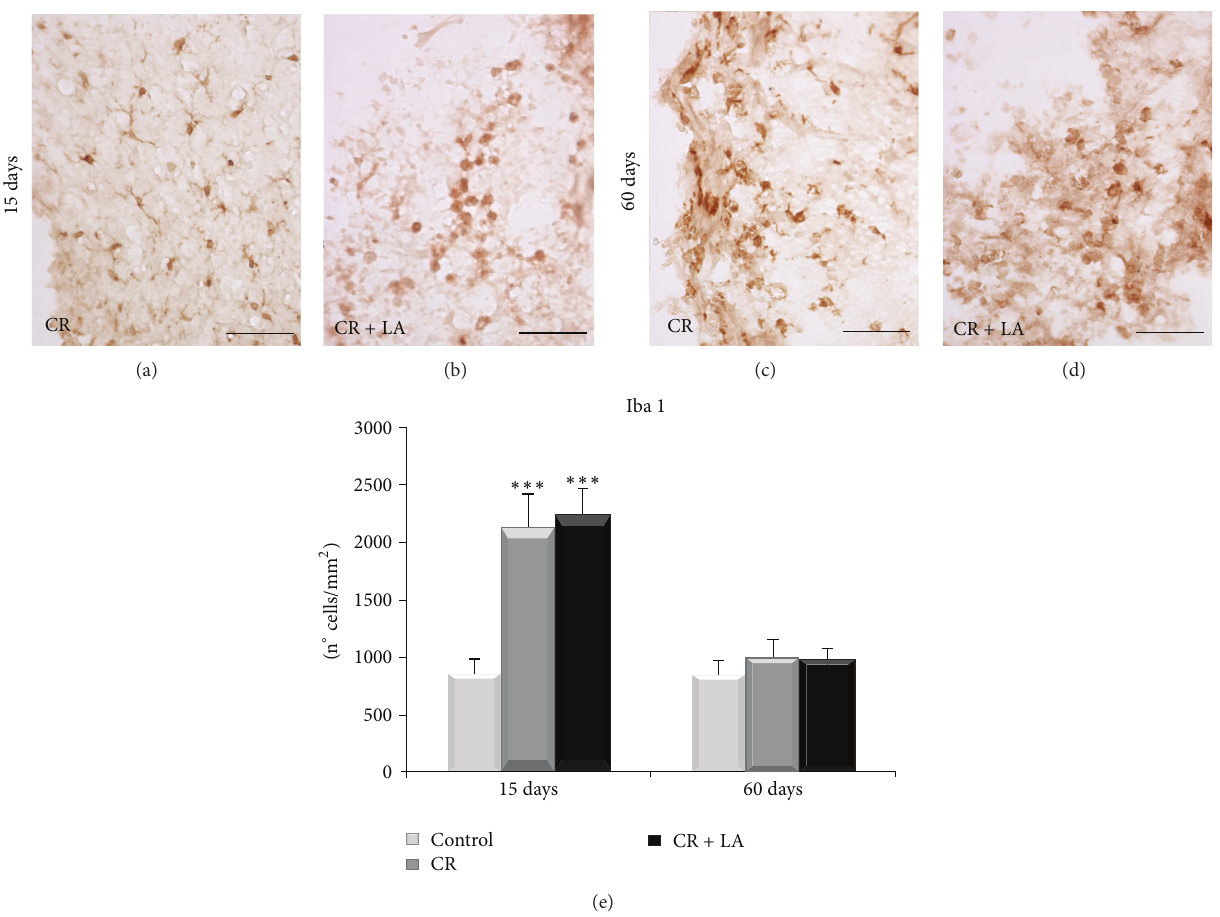
Figure 4: Immunocytochemistry for Iba1 (microglia) at 15 and 60 days in nontreated animals ((a) and (c), resp.) and LA treated animals ((b) and (d), resp.). Quantification of microglial cell density (n ∘ cells/mm 2 ) (e). Scale bar: 100 𝜇 m. ∗∗∗ 𝑃 < 0.001